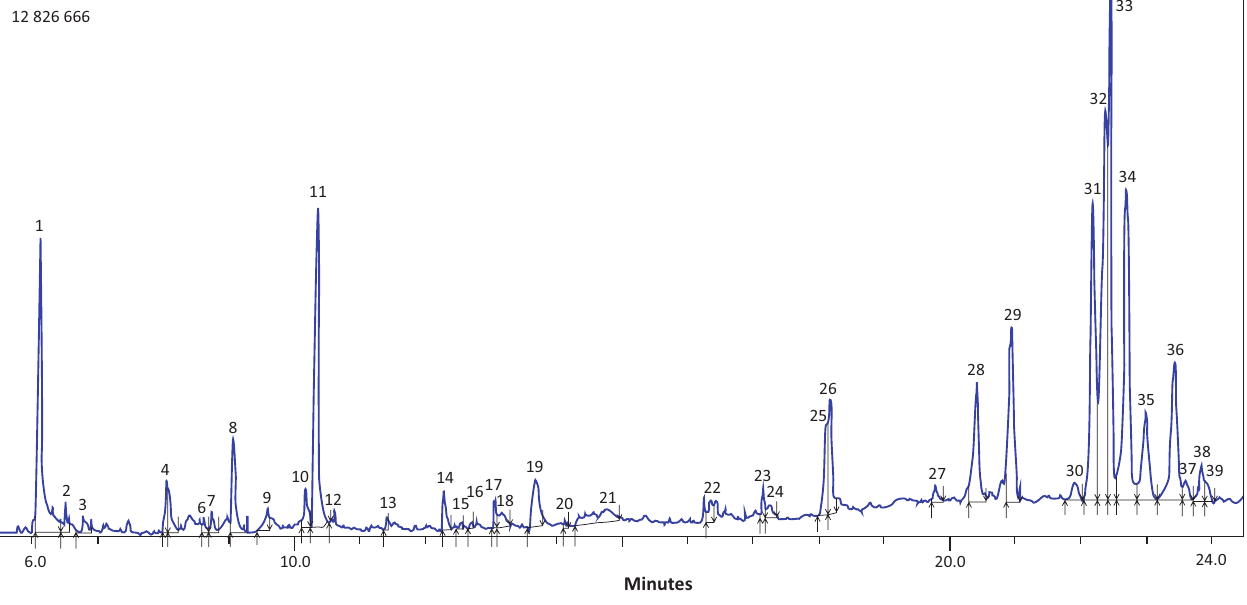
FIGURE 1: Gas chromatography–mass spectrometry chromatogram of the bioactive compounds in the ethyl acetate extract of Adansonia